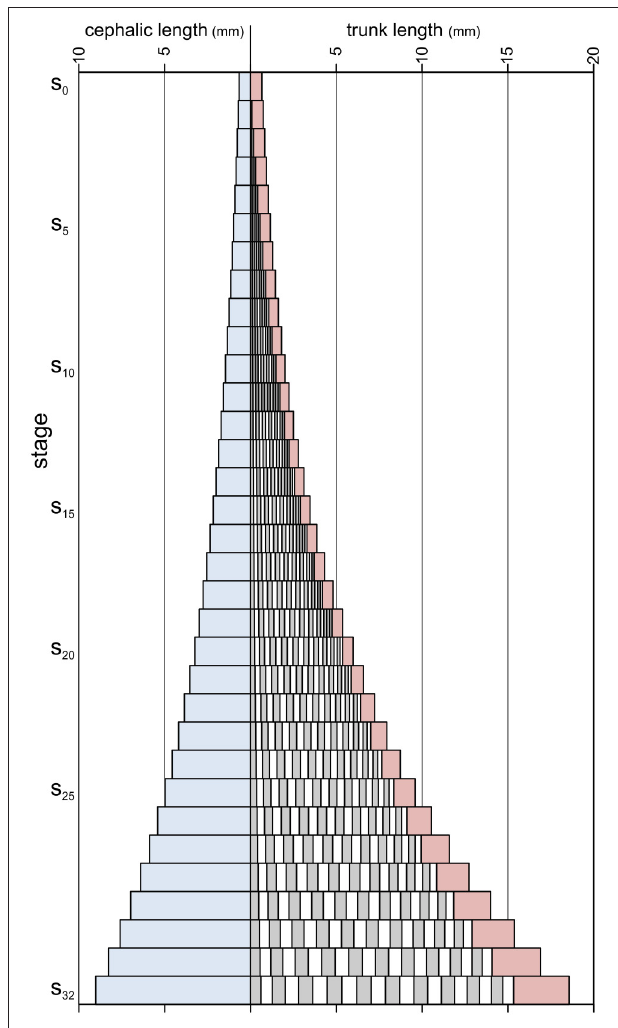
FIGURE 7 | Absolute axial lengths of different body parts during meraspid (stages s 0 –s 19 ) and holaspid (stages s 20 –s 32 ) ontogeny of A. koninckii morphotype t 20 . Cephalic paraxial length, blue; thoracic segments lengths, alternating gray and white; pygidial length,